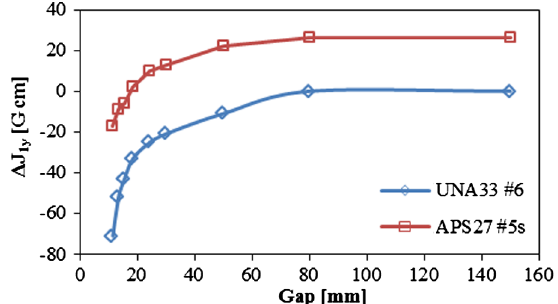
FIG. 2. The difference in first field integrals of two IDs, original and 180° rotated orientations; one ID has a magnetically susceptible frame and the other is nonmagnetic.